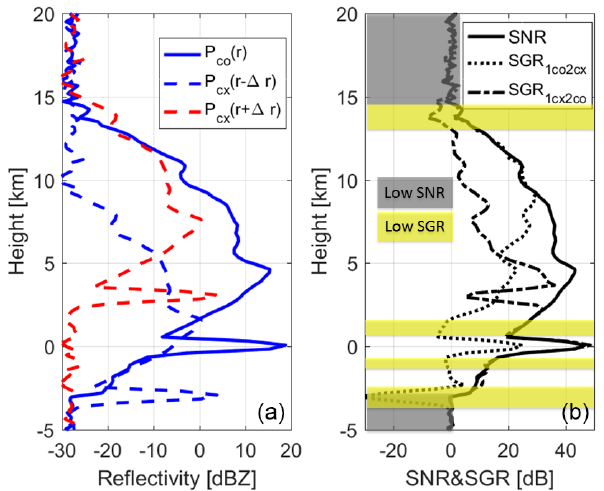
Figure 7. Example of cross talk interference in the PDPP scheme for a reflectivity profile extracted from CloudSat (a − 28dBZ equiv- alent noise power for the H - and V -channel is assumed). (a) The V -pulse produces both a co-polar ( P VV ) and a cx-polar return ( P HV ); the same is true for the H -pulse. An LDR of − 15dB and a T hv = 20µs (corresponding to a height separation of 3km at nadir incidence) are assumed. (b) Signal-to-noise ratio (black) and signal- to-ghost ratios as defined in Eqs. (4)–(5). The gray areas iden- tify regions with SNR < 3dB and the yellow bands regions with SGRs <